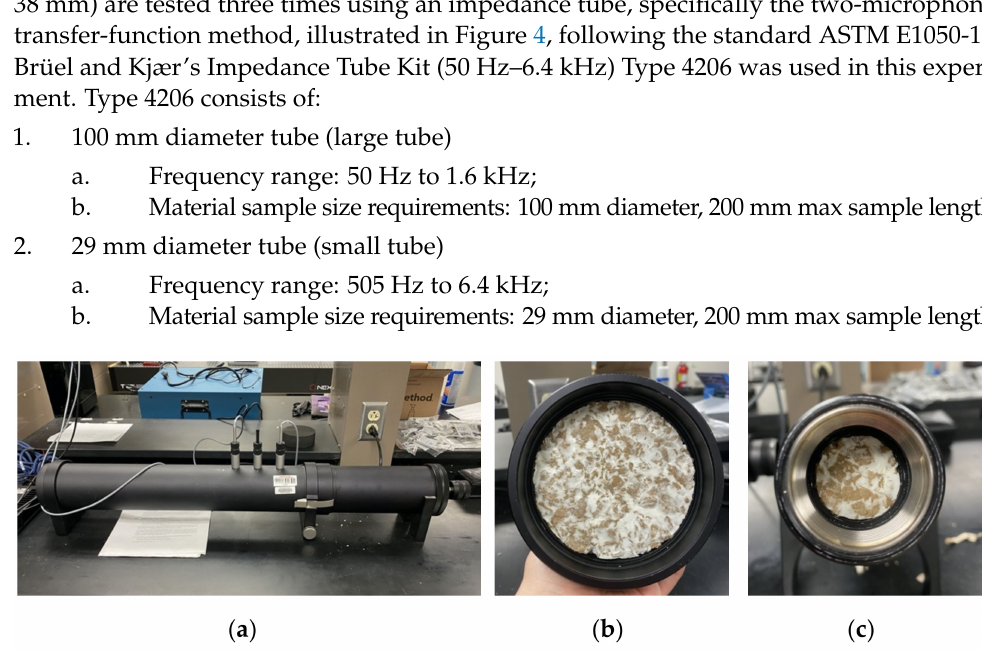
Figure 4. Impedance tube Testing: ( a ) Impedance Tube; ( b ) FCL Sample in the impedance tube; ( c ) FCH sample in the impedance